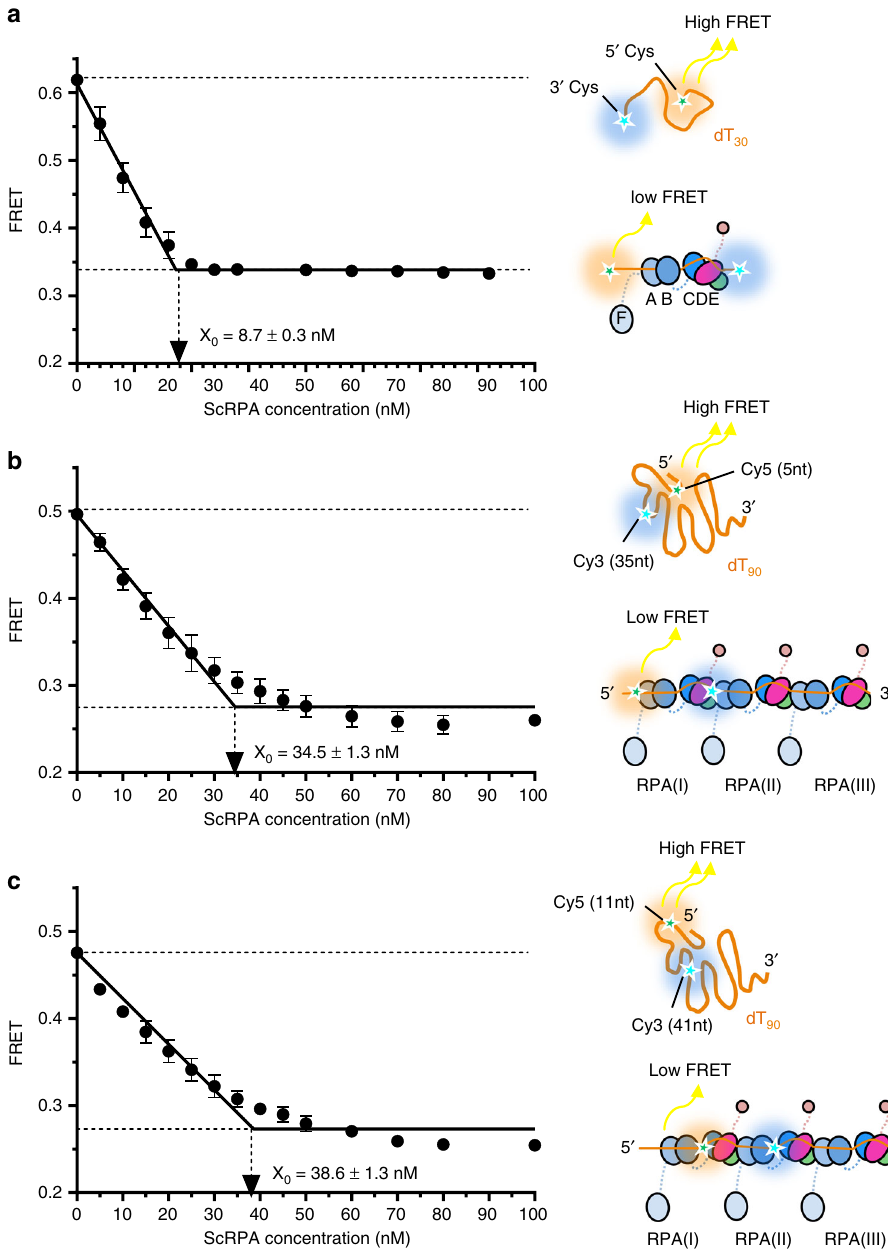
Fig. 4 FRET-based analysis of the RPA-ssDNA complex formation. a Indicated concentrations of ScRPA were added to the solution containing 10 nM dT 30 oligo decorated with the Cy3 dye (FRET donor) at the 3 ′ and the Cy5 dye (FRET acceptor) at the 5 ′ end. Free dT 30 yields a high FRET signal due to the close proximity of the two dyes. Binding of ScRPA straightens the ssDNA thereby increasing the Cy3 – Cy5 distance, which is manifested in the reduction in FRET. Under our experimental conditions, binding is stoichiometric with FRET decreasing linearly until the saturation is reached at approximately one ScRPA heterotirimer per one molecule of dT 30 ( X 0 = 8.7 ± 0.3 nM). The experiment was repeated twice and data points are an average with standard deviation (SD). b , c Indicated concentrations of ScRPA were added to the solution containing 10 nM dT 90 oligo decorated with the Cy3 and Cy5 dye separated by 30 nucleotides. In dT 90 (5 – 35) Cy5 is 5 nt from the 5 ′ end and Cy3 is 35 nt from the 5 ′ end ( b ), whilst dT 90 (11 – 41) Cy5 is 11 nt from the 5 ′ end and Cy3 is 41 nt from the 5 ′ end ( c ). In both cases the saturation of the FRET signal is achieved at about three ScRPA molecules per dT 90 . Due to the dye positions, dT 90 (5 – 35) reports on the ssDNA geometry within the RPA most proximal to the 5 ′ end, while dT 90 (11 – 41) reports on the ssDNA arrangement between the TriC of the fi rst RPA and the DBD-A and DBD-B of the second RPA. In b , c the experiments were repeated three times and data points are an average with SD. In all data plotted, a cartoon is shown to illustrate the FRET experiment setup and the low and high FRET states observed. Source data are provided as a Source Data fi FRET was monitored as the RPA molecules formed cooperative RPA with DBD-D (Tri-C) of an adjacent molecule (Fig. 6f). complexes on increasing lengths of ssDNA in a stopped fl ow Indeed, stopped- fl ow fl uorescence data (Fig. 6g) shows the experiment (Fig. 6e). Structural models suggest that the high production of a FRET signal in the presence of ssDNA and we FRET signal can only arise from close proximity of DBD-A of one observe three key features.